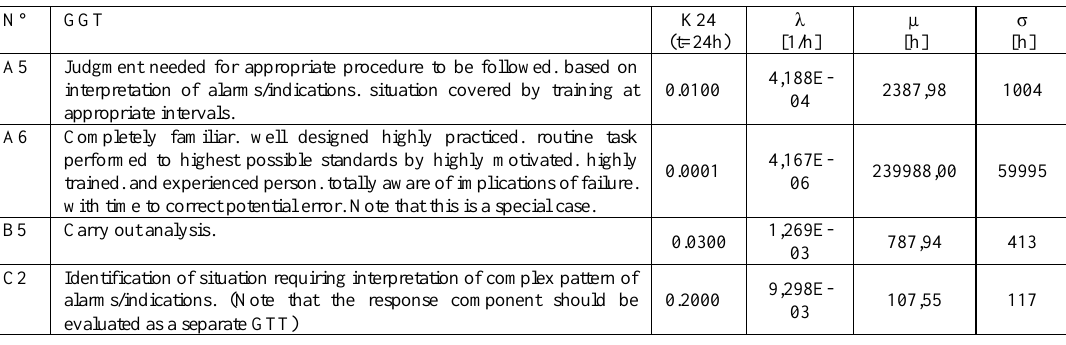
Table 4. GTTs of the control room